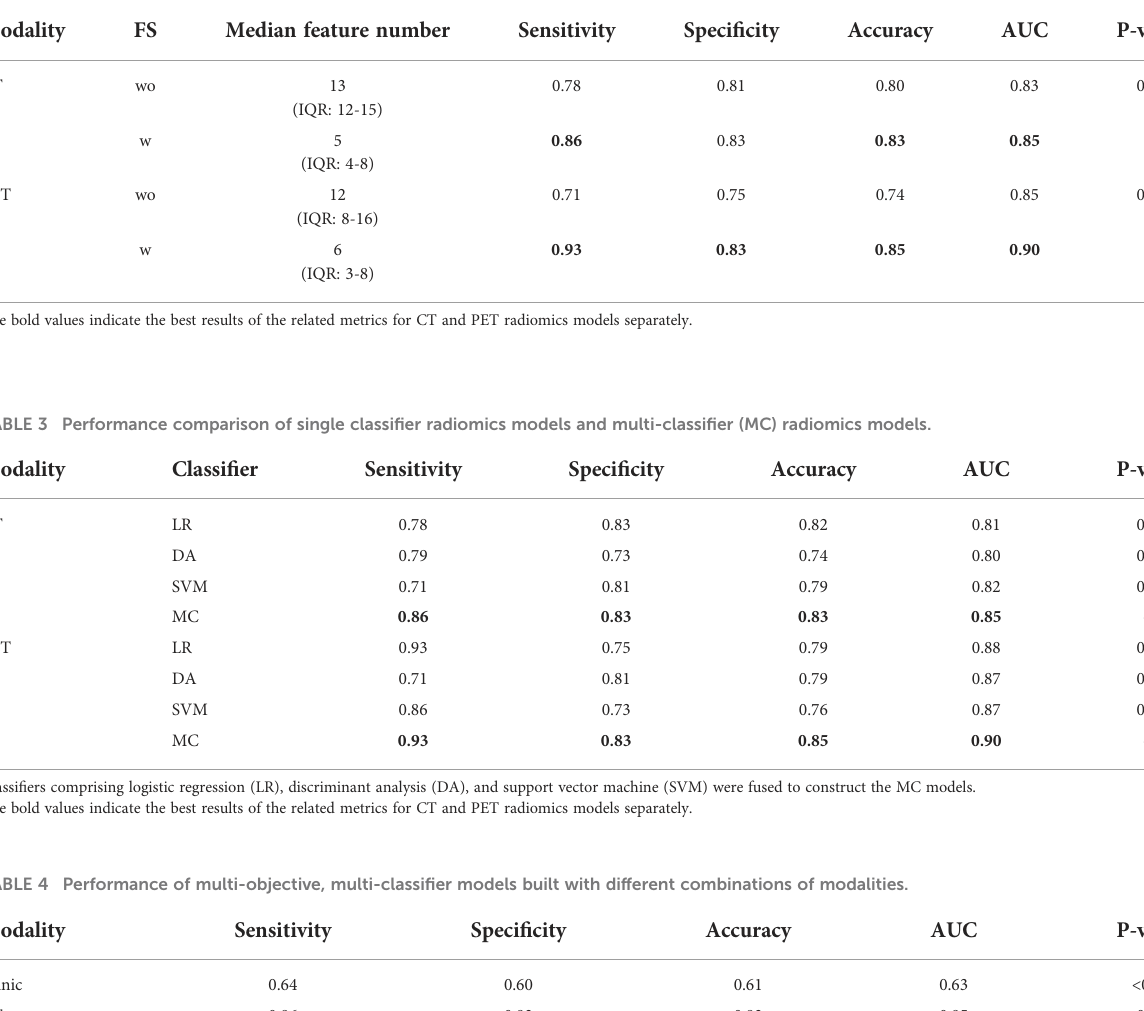
TABLE 2 Performance comparison of multi-classi fi er multi-objective radiomics models trained with and without feature sparsity (FS) as objective. Modality